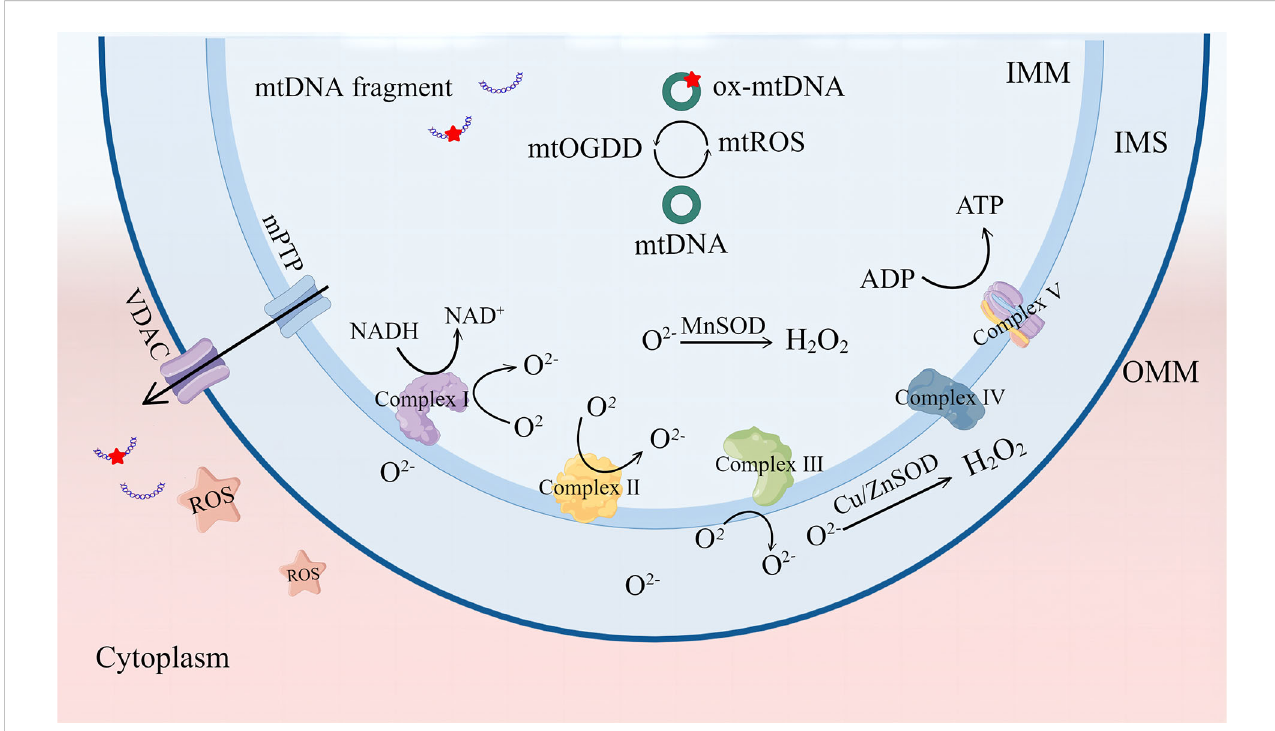
FIGURE 1 The mitochondrial respiratory chain complex is the main site for ROS production. ROS can be catalyzed as H 2 O 2 by MnSOD or Cu/ZnSOD, and ROS accumulation causes mtDNA damage and leakage into the cytoplasm through mPTP and VDAC channels. VDAC, voltage-dependent anion channel. mPTP, mitochondrial permeability transition pore. ROS, reactive oxygen species. SOD, superoxide dismutase; IMM, inner mitochondrial membrane; IMS, intermembrane space; OMM, mitochondrial outer membrane. By